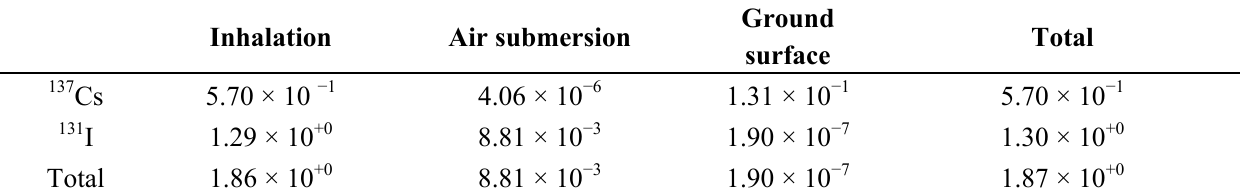
Table 2. Effective dose at Hongnong in case of nuclear accident at the YeoungKwang nuclear power plant (unit: mSv).